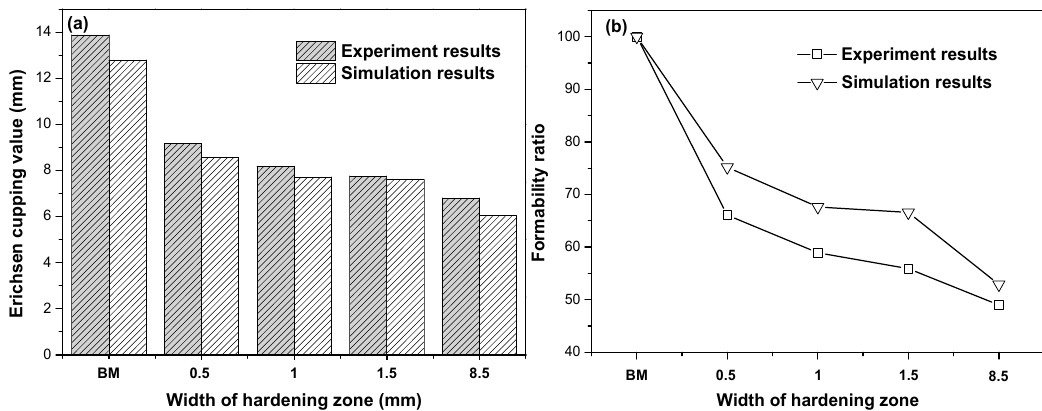
Figure 11. Experimental and simulated result of ( a ) cupping values and ( b ) the formability ratio.